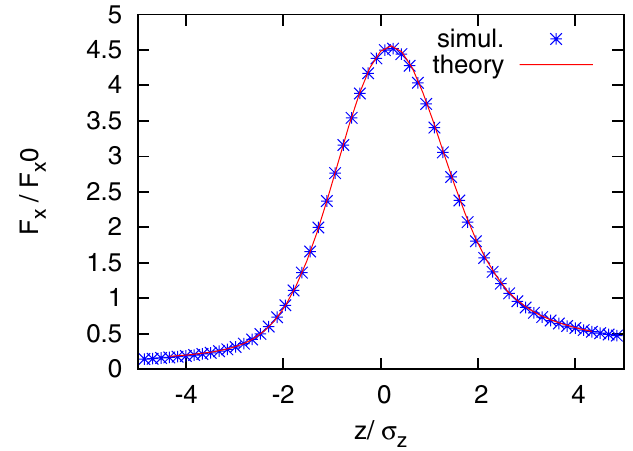
FIG. 9. (Color) Transverse coherent synchrotron radiation force in steady state as a function of z , taken along the center x; y (cid:1) 0 of a three-dimensional Gaussian bunch given by simulation (shown in circles). The theoretical value (line) was calculated by numerical integration of Eqs. (16) and (17). The longitudinal and the force is coordinate z is scaled to the rms bunch length (cid:4) z (cid:1) 2 Ne 2 =R scaled by F x 0